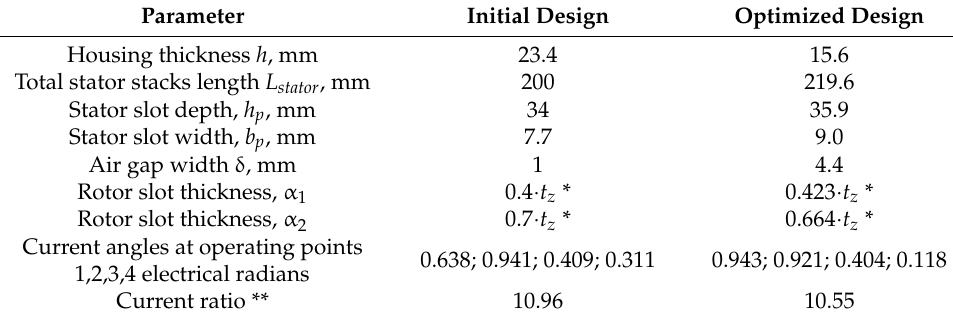
Table 4. Variable motor